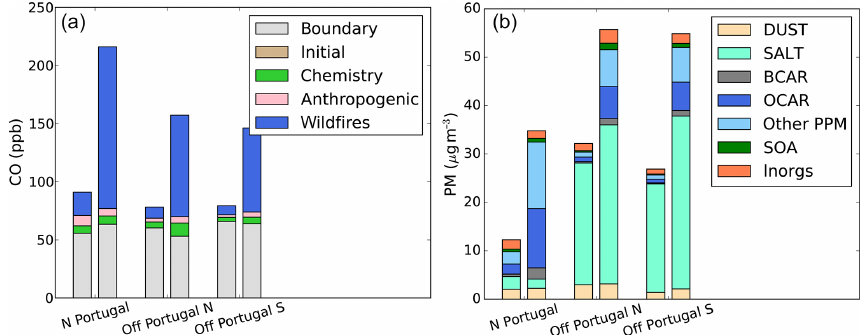
Figure 10. Average surface concentrations of CO (a) and PM 10 (b) over the subregions depicted in Fig. 9 (northern Portugal above the fires and off the coast of northern Portugal and off southern Portugal in the transported fire plume) with contributions from the different CO tracers and aerosol species: dust, sea salt (SALT), black carbon (BCAR), organic carbon (OCAR), secondary organic aerosols (SOA), and inorganic aerosols (Inorgs; including sulfate, nitrate, ammonium), and other primary particulate matter (Other PPM). For each region, the left bar is averaged over the whole summer, while the right bar corresponds to the intense fire episode at the beginning of August (8–14 August